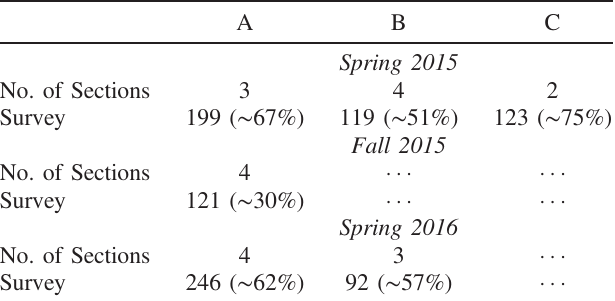
TABLE I. Respondent breakdown by institution. (Percent of students participating is estimated by the maximum class